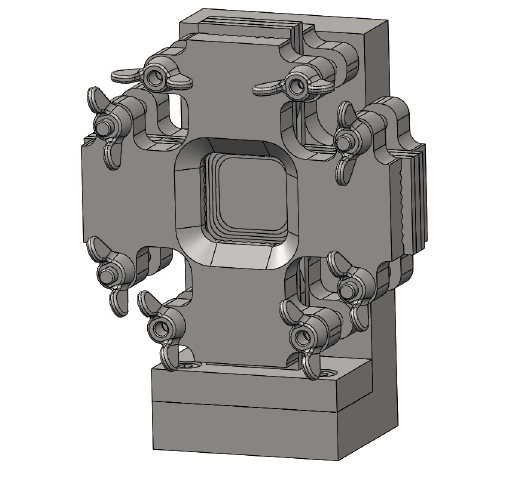
Figure 5. 3D model of the anti-buckling device developed by Serna Moreno and Horta Muñoz